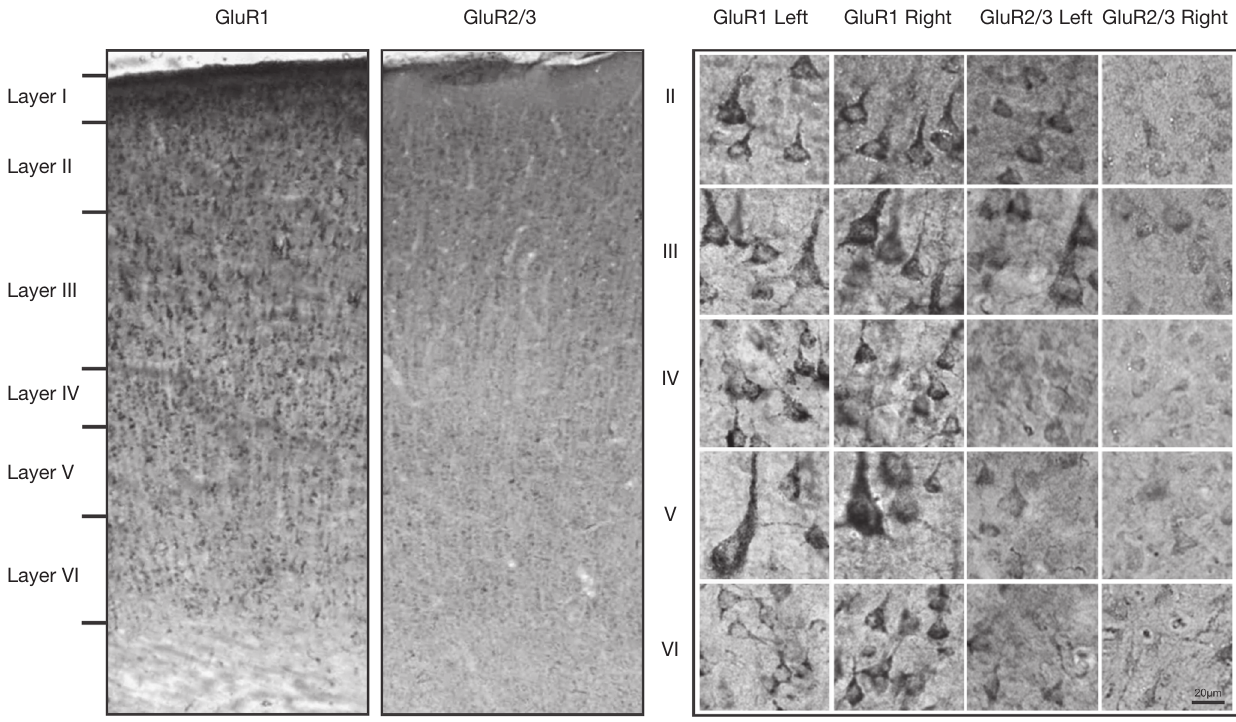
those reported in macaques. Right: Higher-power images of neurons stained with GluR1 and GluR2/3 in the deprived and control hemisphere. Left cortex is control and right cortex is deprived.